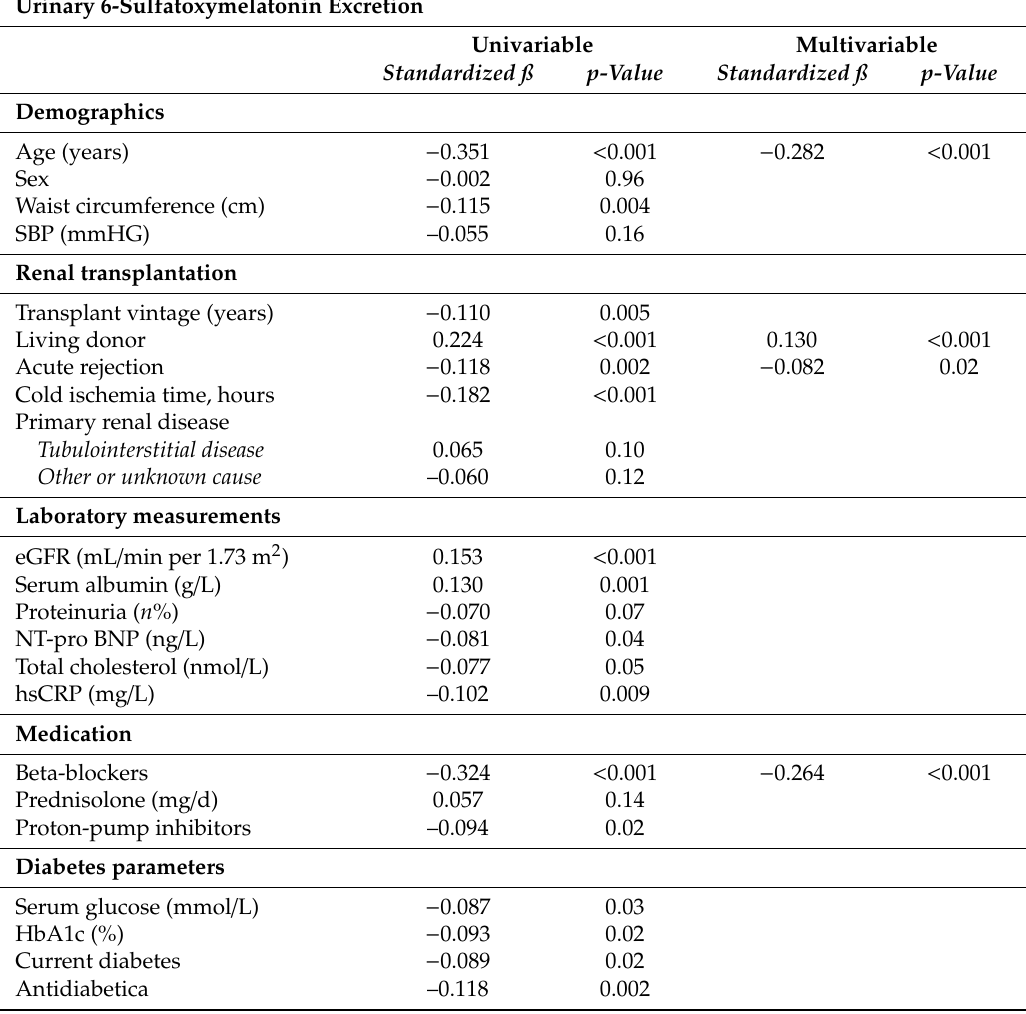
Table 3. Univariable and multivariable associations of 6-sulfatoxymelatonin excretion with clinical parameters in 665 RTRs (without diabetic nephropathy)